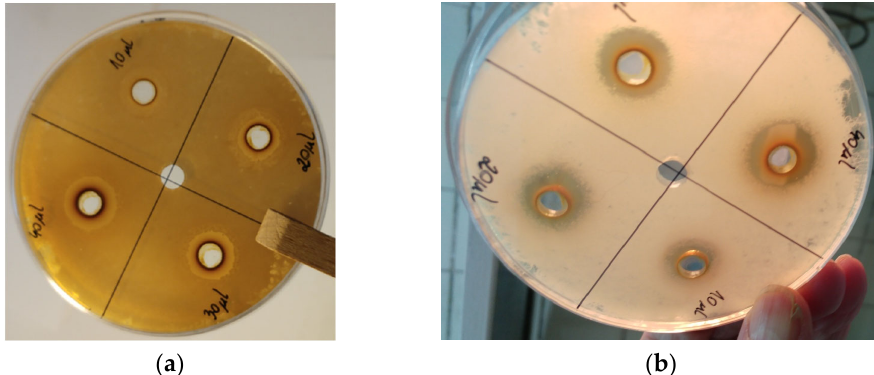
Figure 2. Methods of application of plant preparation to Trypticase Soy Agar using the well method against ( a ) Escherichia coli and ( b ) Bacillus sp.